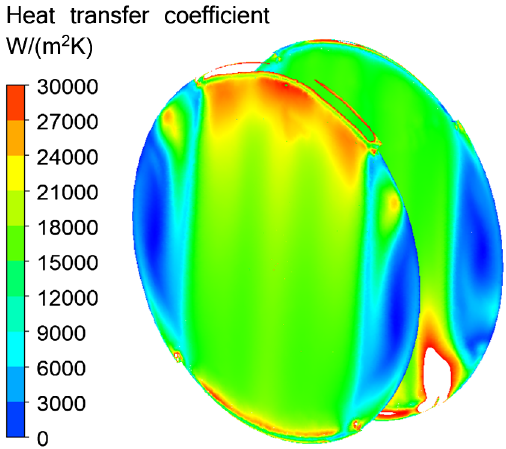
FIG. 11. Heat transfer coefficient (HTC) distribution in the front and back surfaces of block 4. The average HTC found in the surfaces is around 15000 W = ð m 2 K Þ .